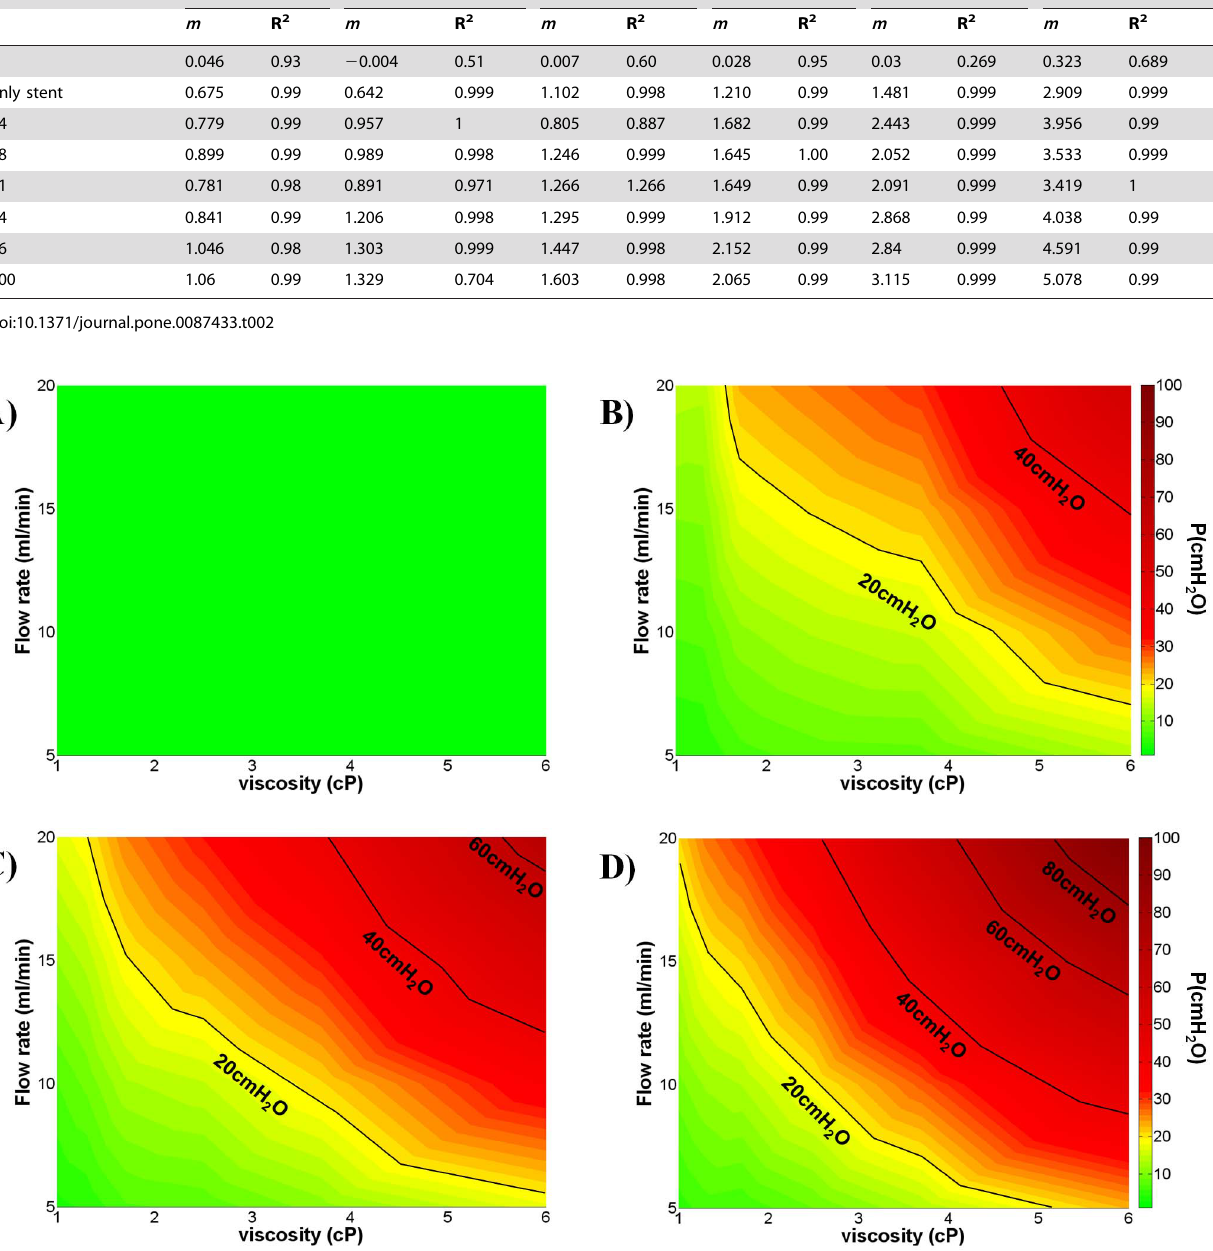
Figure 6. Dependence of UM renal pelvic pressure on fluid flow rate, dynamic viscosity and severity of obstruction. Colourmaps show the dependence of ureteric model (UM) renal pelvic pressure on both the fluid flow rate ( Q in ml/min, y-axis) and the fluid dynamic viscosity ( m in cP, x-axis). Colours correspond to different pressure values (in cmH 2 O) reported in the colourbar on the right hand side. A) OB%=0, corresponding to unobstructed UM (absence of both plastic sphere and stent). B) refers to the condition of obstruction-causing effects, due to the stent only (absence of plastic sphere). Adding the plastic sphere, two values of severity of obstruction were considered: C) OB%=88 and D) OB%=100 (stent + plastic sphere, with hole size according to Eq. 1). Iso-pressure lines (in cmH 2 O) are reported (black lines). The green area corresponds to the safe region ( P , 15 cmH 2 O), the yellow area to the warning region (15 , P , 20 cmH 2 O) while the orange/red area to the dangerous region ( P . 20 cmH 2 O) for correct kidney functioning.